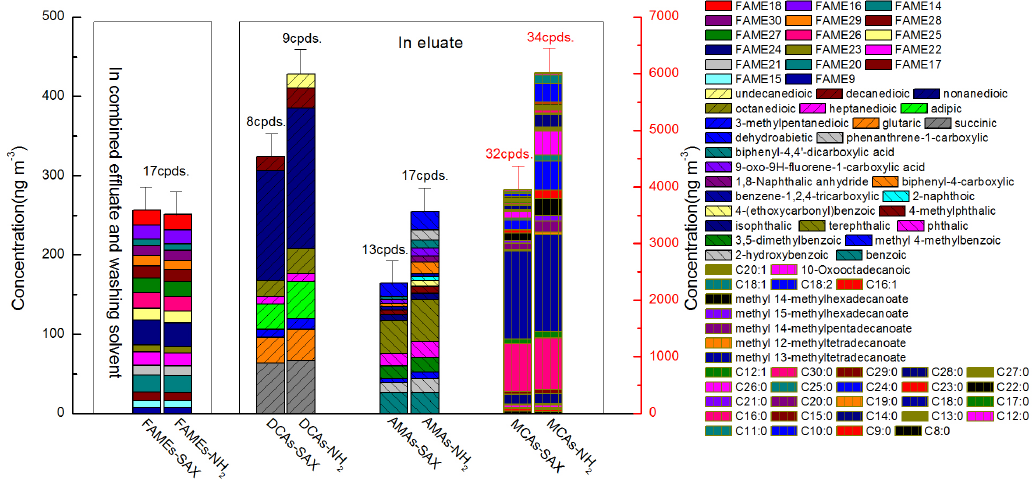
Figure 1. Concentrations of analytes found when an extract of PM 2 . 5 collected on 1 January 2013 in Beijing was analyzed using the SAX and NH 2 SPE cartridges. The left-hand y axis (in black) is for the DCAs, AMAs, and fatty acid methyl esters. The right-hand y axis (in red) is for the MCAs. The T-shaped marks indicate the numbers of compounds (cpds.) that were found.